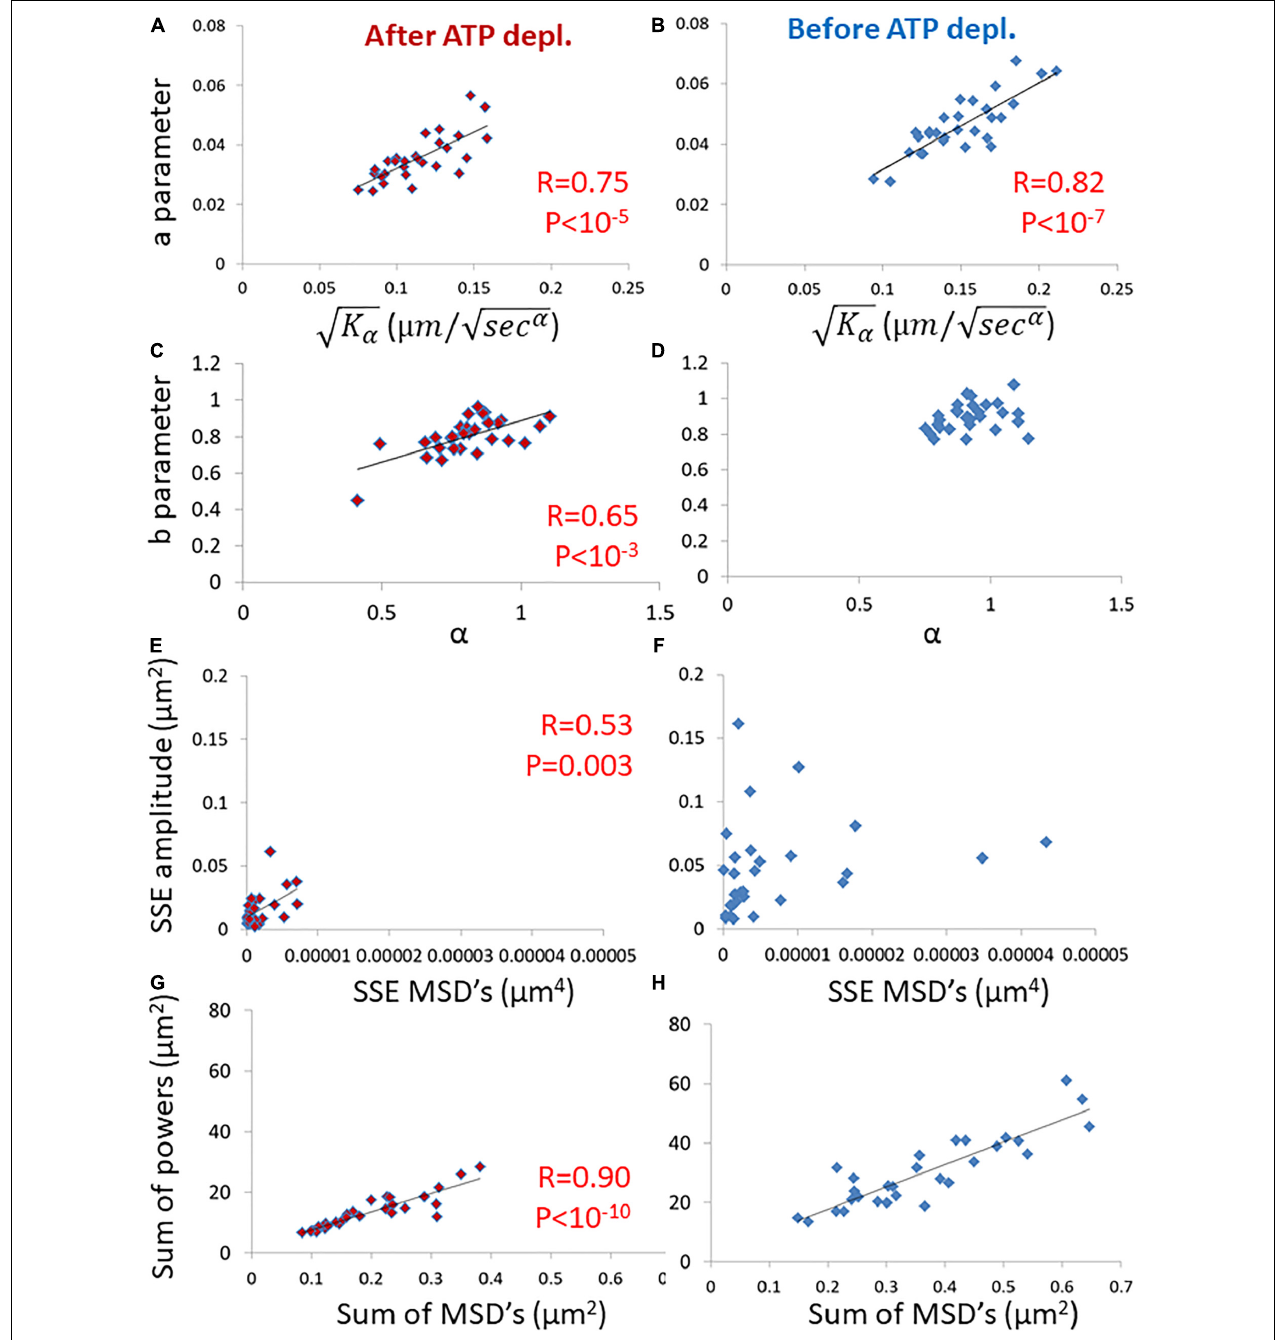
FIGURE 4 | Correlation of amplitude spectral density (ASD)/ power spectral density (PSD) parameters and mean square displacement (MSD) parameters in live cells √ before and after adenosine triphosphate (ATP) depletion. (A) The correlation between the a parameter of ASD analysis and K α of MSD analysis in ATP-depleted cells. Analyses relate to DIC microscopy results of intracellular particles motion of shown in Figure 3 ( n = 29). (B) The correlation between the a parameter of ASD √ analysis and K α of MSD analysis in cells before ATP depletion. (C) The correlation between the b parameter of ASD analysis and α of MSD analysis in ATP depleted cells. (D) The correlation between the b parameter of ASD analysis and α of MSD analysis in cells before ATP depletion. (E) The correlation between the SSE parameter of ASD analysis and SSE of power fit to MSD analysis in ATP depleted cells. (F) The correlation between the SSE parameter of ASD analysis and the sum of squared errors (SSE) of power fit to MSD analysis in cells before ATP depletion. (G) The correlation between “Sum of powers” parameter of PSD analysis and sum of MSD’s parameter (from MSD analysis) in ATP depleted cells. (H) The correlation between “Sum of powers” parameter of PSD analysis and sum of MSD’s parameter (from MSD analysis) in cells before ATP depletion. R - and P -values of significant correlations are presented in the corresponding correlations images.